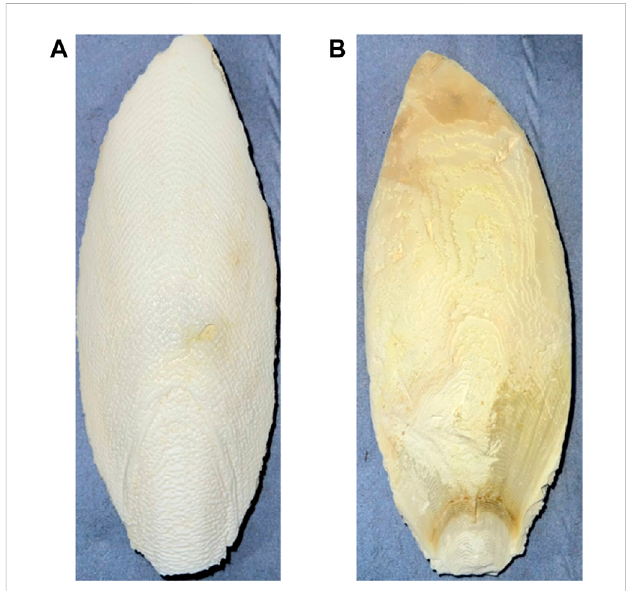
CFB used for this study: (A) front side and (B) back